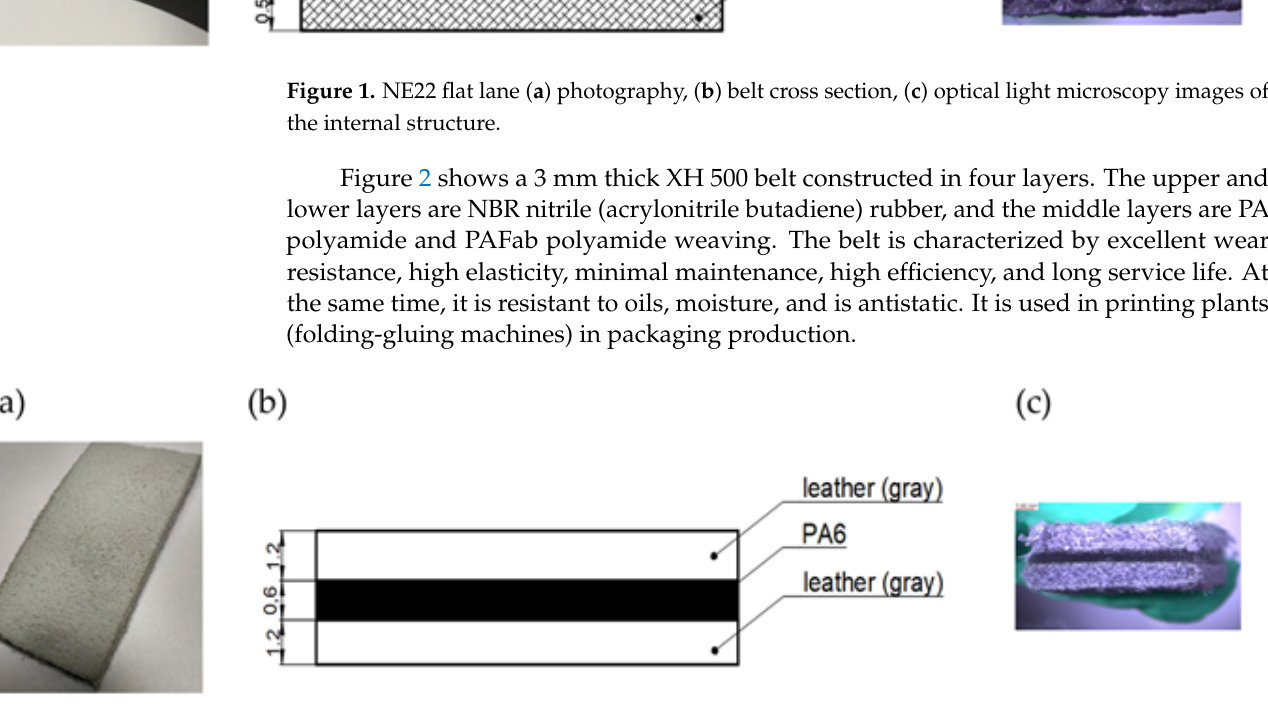
Figure 2. LL2 flat lane ( a ) photography, ( b ) belt cross section, ( c ) optical light microscopy images of the internal structure.